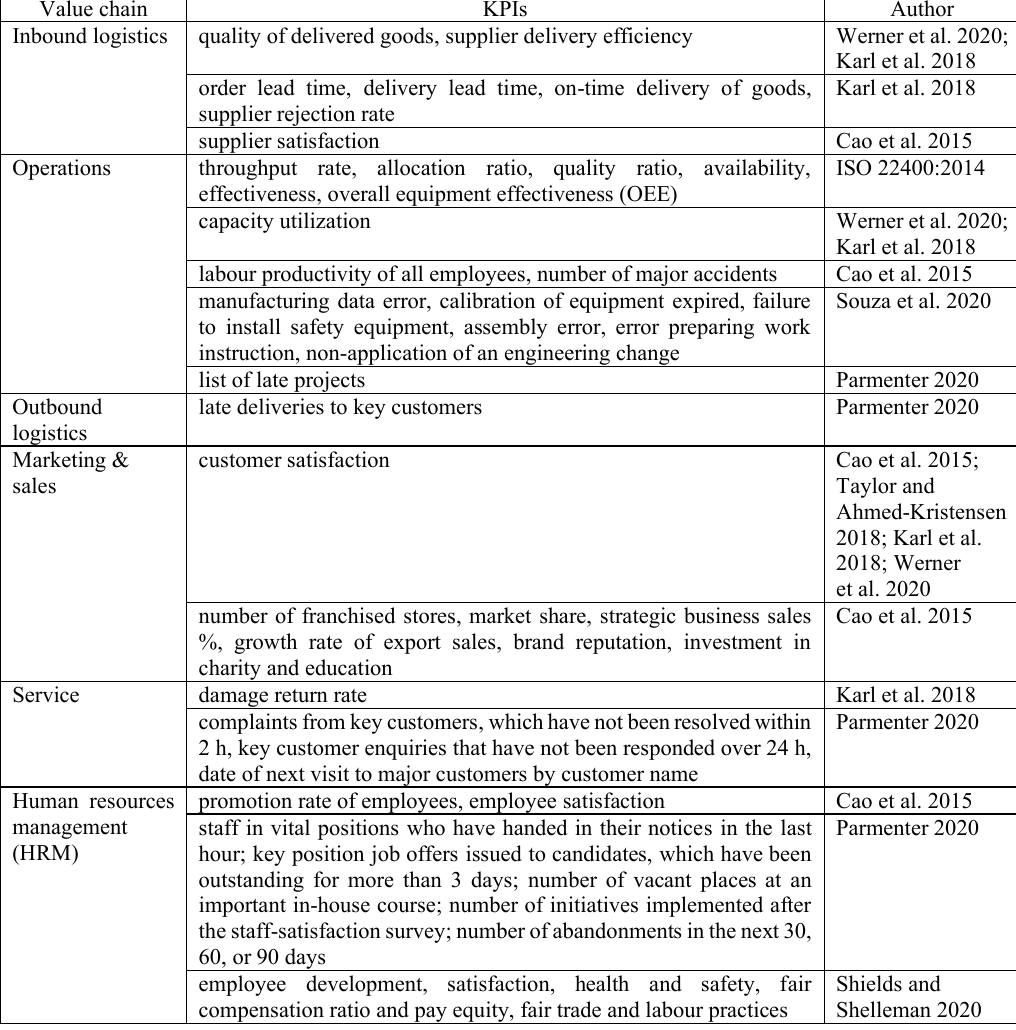
Table 1. KPIs overview by the value chain